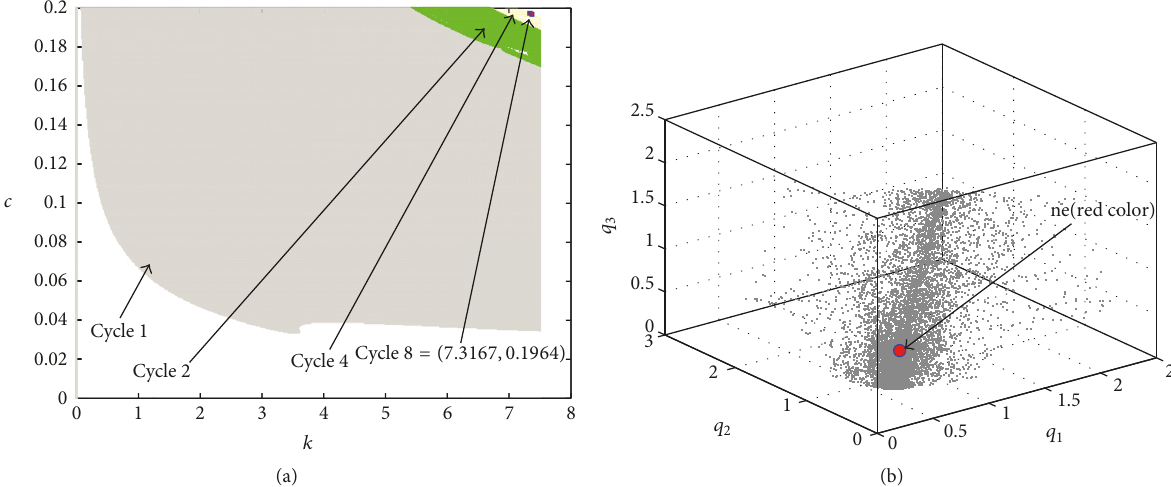
Figure 9: (a) 2D bifurcation diagram of 𝑘 versus 𝑐 at 𝑞 0,1 = 0.11 , 𝑞 0,2 = 0.12 , and 𝑞 3,0 = 0.13 . (b) Phase portrait at 𝑘 = 7.8 , 𝑐 = 0.2 , 𝑞 0,1 = 0.11 , 𝑞 = 0.12 , and 𝑞 = 0.13 . 0,2 3,0